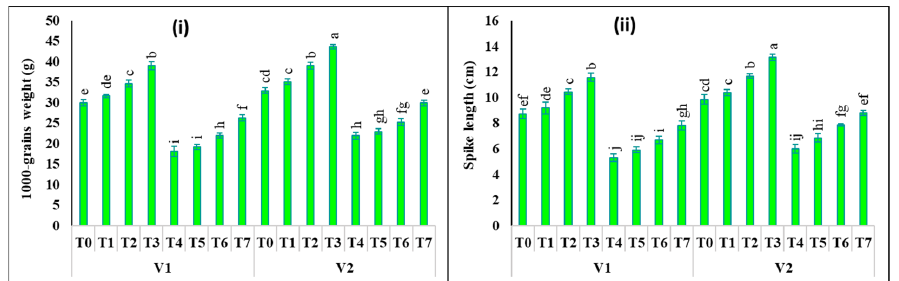
Figure 7. Influence of salicylic acid priming on ( i ) 1000-grains weight and ( ii ) spike length under salt stress; T0 (control), T1 (hydropriming), T2 (10 mM SA priming), T3 (20 mM SA), T4 (170 mM NaCl), T5 (170 mM NaCl+ hydropriming), T6 (170 mM NaCl+10 mM SA priming), and T7 (170 mM NaCl+20 mM SA priming); bars sharing same case letter or without lettering, for a parameter, do not significantly differ ( p ≤ 0.05) by the LSD test.